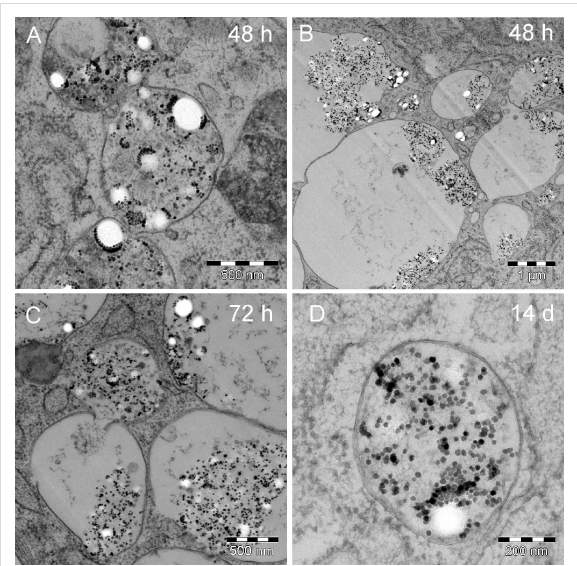
Figure 7: TEM bright field micrographs of endosomes observed in the MSCs at different residence times of PLLA nanoparticles. These images only provide an excerpt of the different endosomes observed for each observation time. At the 48 h time point, approximately 500 nm-sized endosomes become filled with external material (A). Ad- ditionally, “giant endosomes” were found (B). These could be found after 72 h as well (C) amongst others. Even after 14 days, the MSCs contain endosomes engulfing PLLA nanoparticles and magnetite nanocrystals (D).